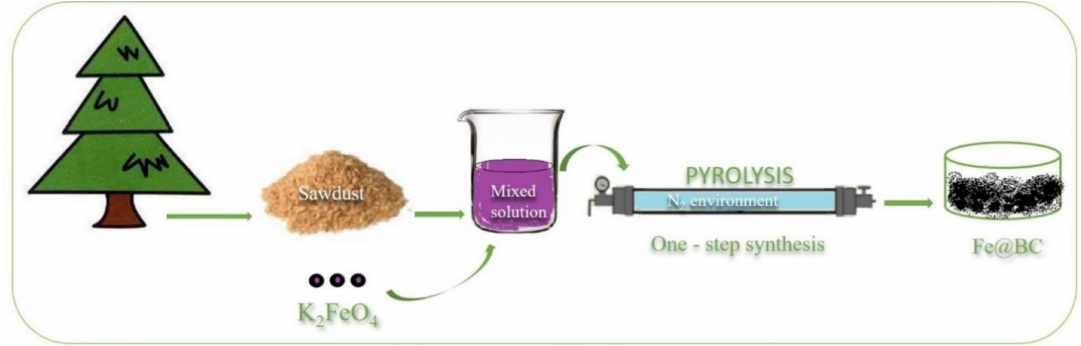
Figure 1. One-step synthesis of porous graphitic